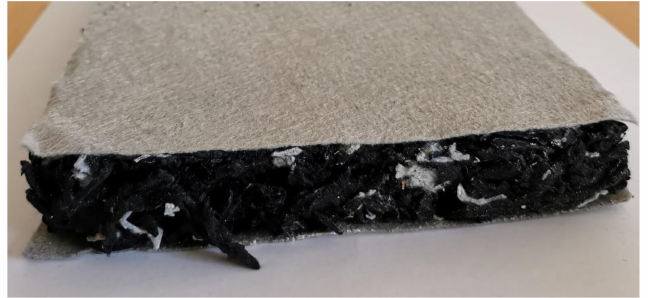
Figure 2. Thermal insulation slab made of shredded compressed waste polyester nonwoven